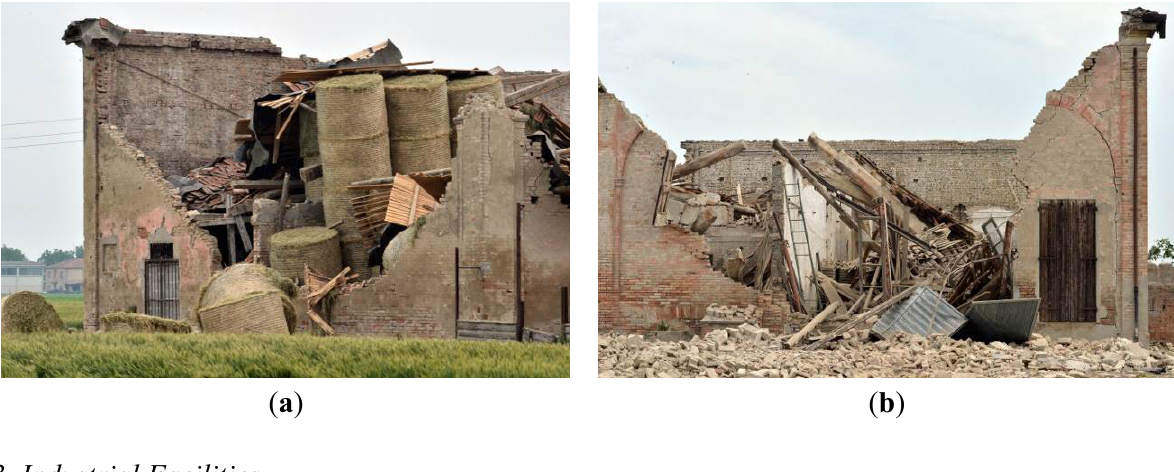
Figure 3. Collapse of rural masonry buildings: ( a ) Corner mechanism; ( b ) Out-of-plane mechanism of wall.